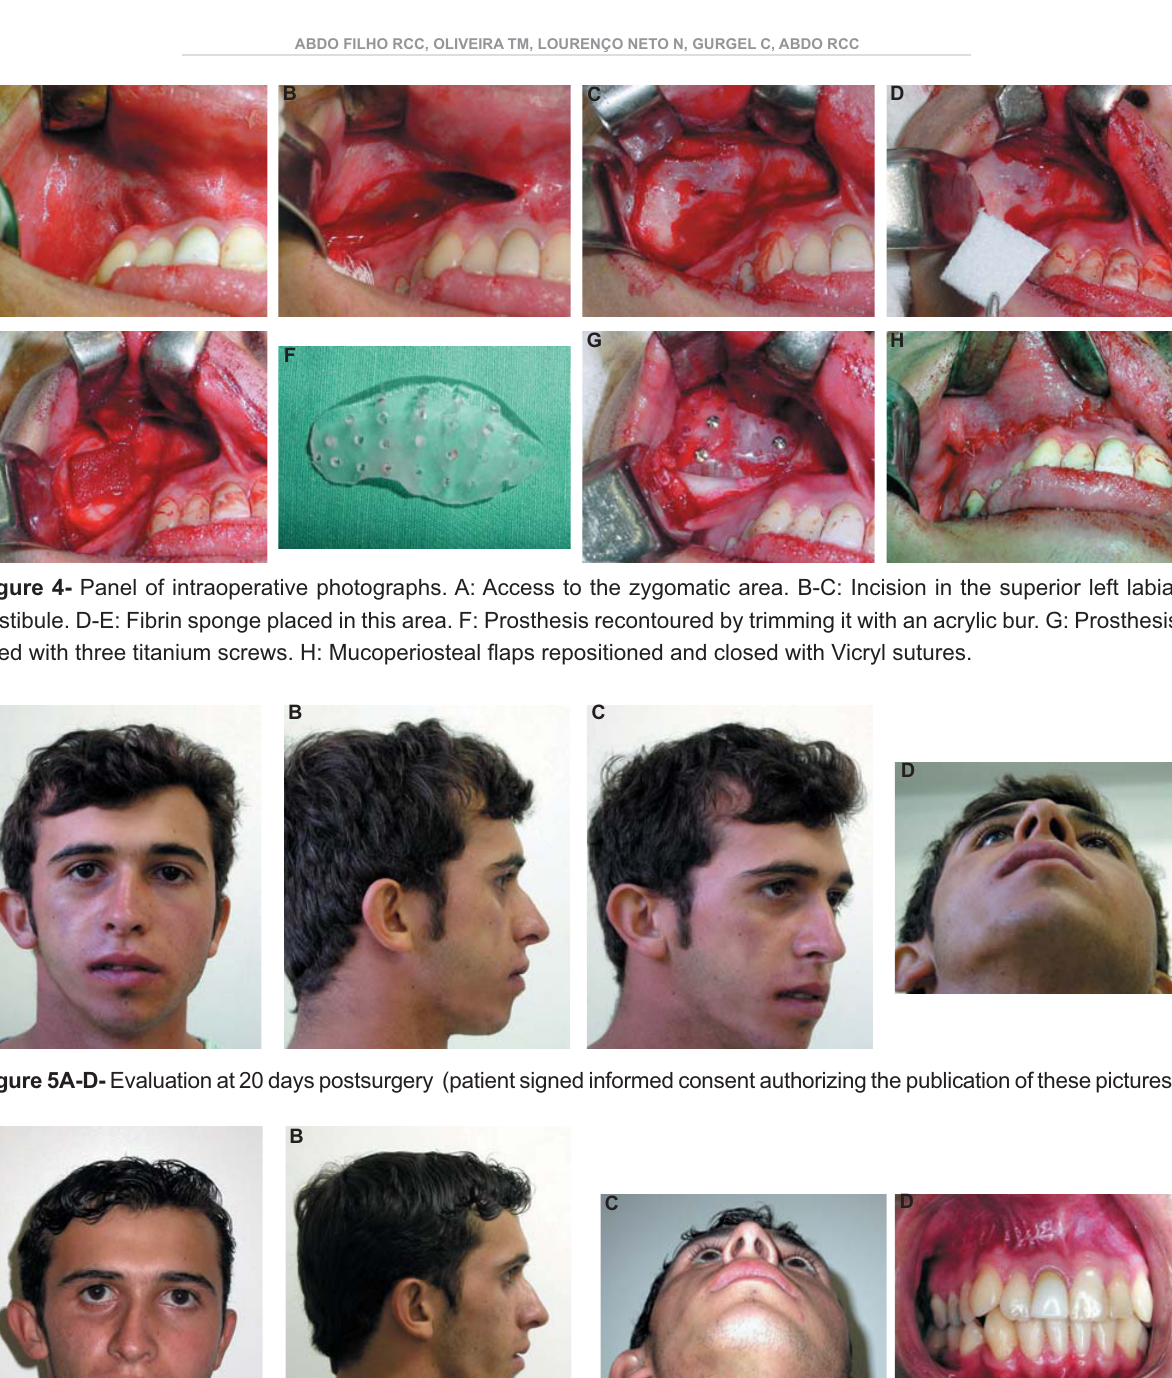
Figure 6A-D- Follow-up of 36 months (patient signed informed consent authorizing the publication of these pictures)